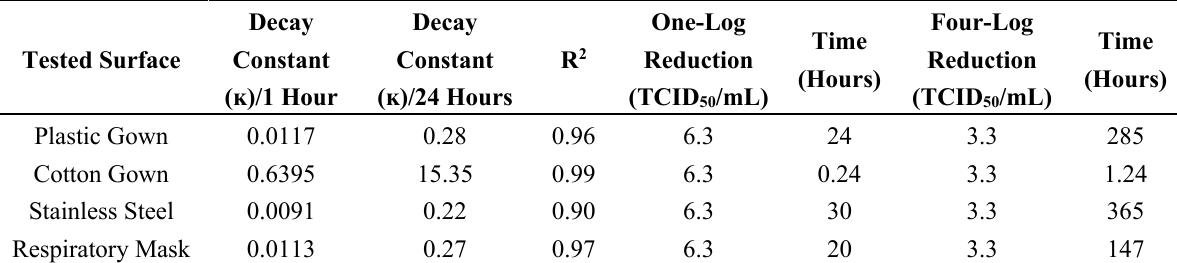
Table 1. Results of non-linear regression analysis for modeling the exponential decay of EBOV/Mak virus 7.3 TCID 50 /mL (t = 0) on the tested surfaces. The fitted models were utilized to calculate the time until one and four-log reductions in viral titer occur from the initial viral